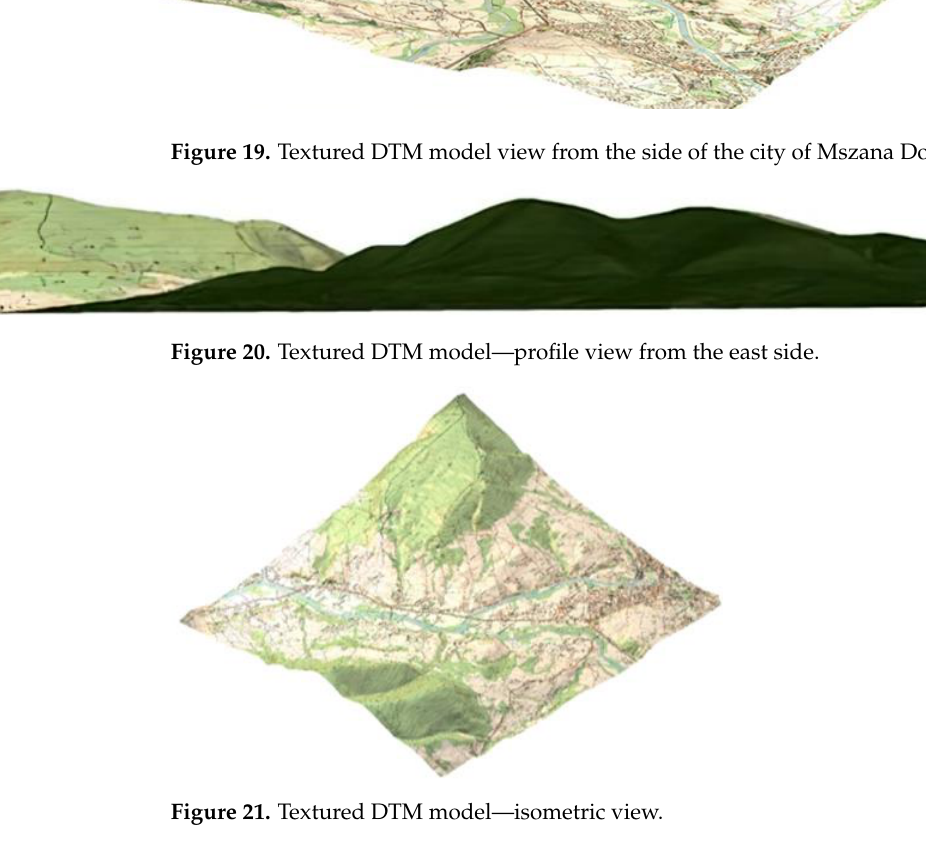
Figure 22. Textured DTM model — top view.